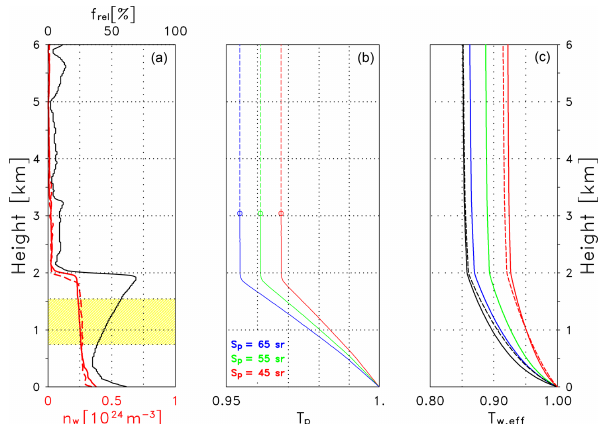
Figure 15. Analogously to Fig. 11, the conversion function η is at 905nm (red) and 915nm (blue) for Case B. The dashed lines are for constant Angström exponents κ as indicated, whereas the solid line is for the height-dependent κ(z) . The validation range (in yellow) was set to 0.75 and 1.55km. Table 5. Relevant criteria of the validation for Case B. The mini- mum slope d F/ d z for an integer wavelength is given, or d F/ d z = 0 if the corresponding curve shown in Fig. 16 crosses the zero line (for an noninteger wavelength). According to Eq. (17) the decrease in the range-corrected signal s should be 1 . 09 < s < 1 . 15. A height- dependent κ(z) is